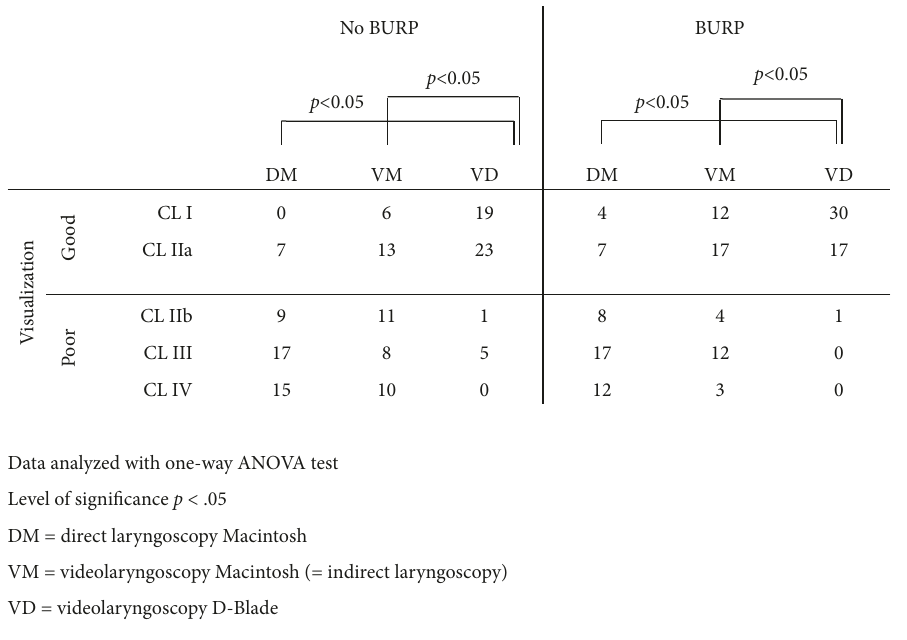
Figure 3: Results of examination of glottis view using the Cormack-Lehane score. Table 1: Demographic data.